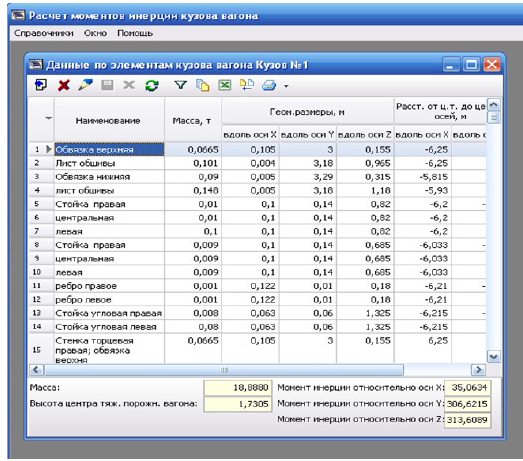
Figure 9. The wagons parameters panel “Software complex for determining the moments of inertia of wagons